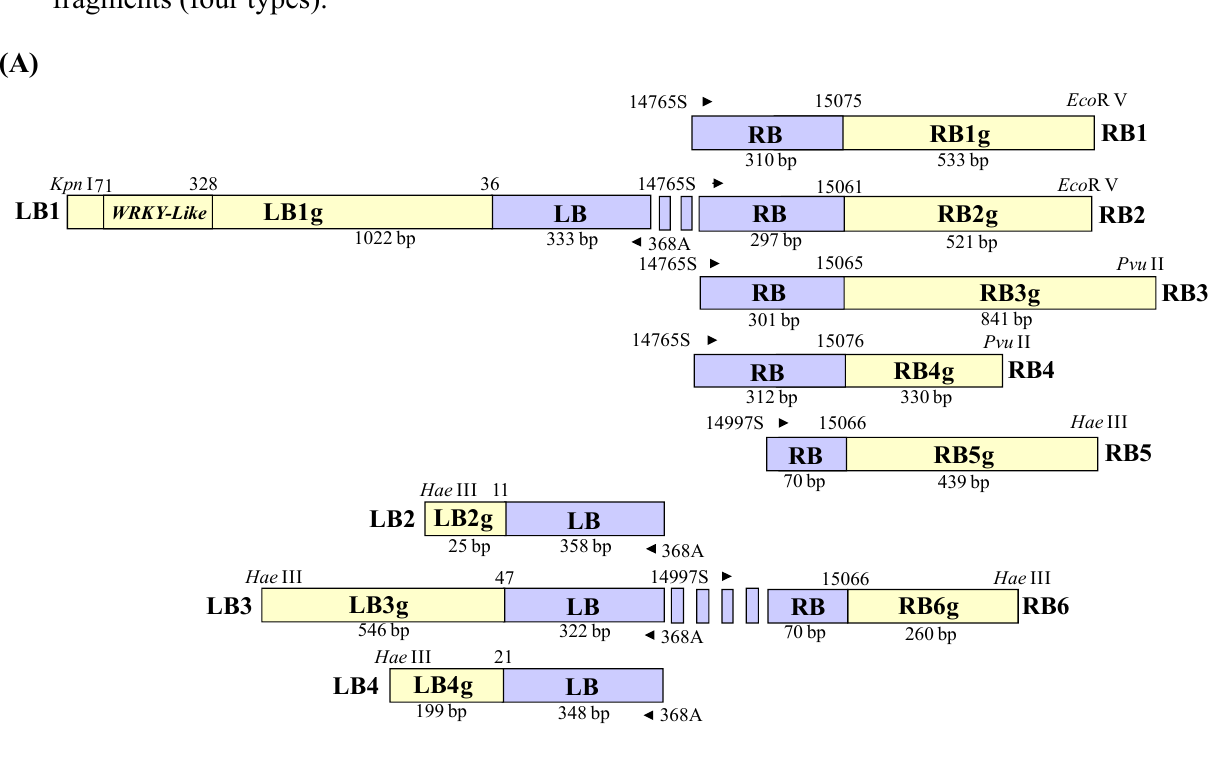
Figure 5. Schematic diagram of amplified fragments obtained in the analyses of T-DNA . ( A ) T-DNAs connected with P.somniferum genome (10 types, eight insertion loci in T 0 sites), ( B ) T-DNAs connected in tandem (six types), ( C ) T-DNAs connected with orf13 fragments (four